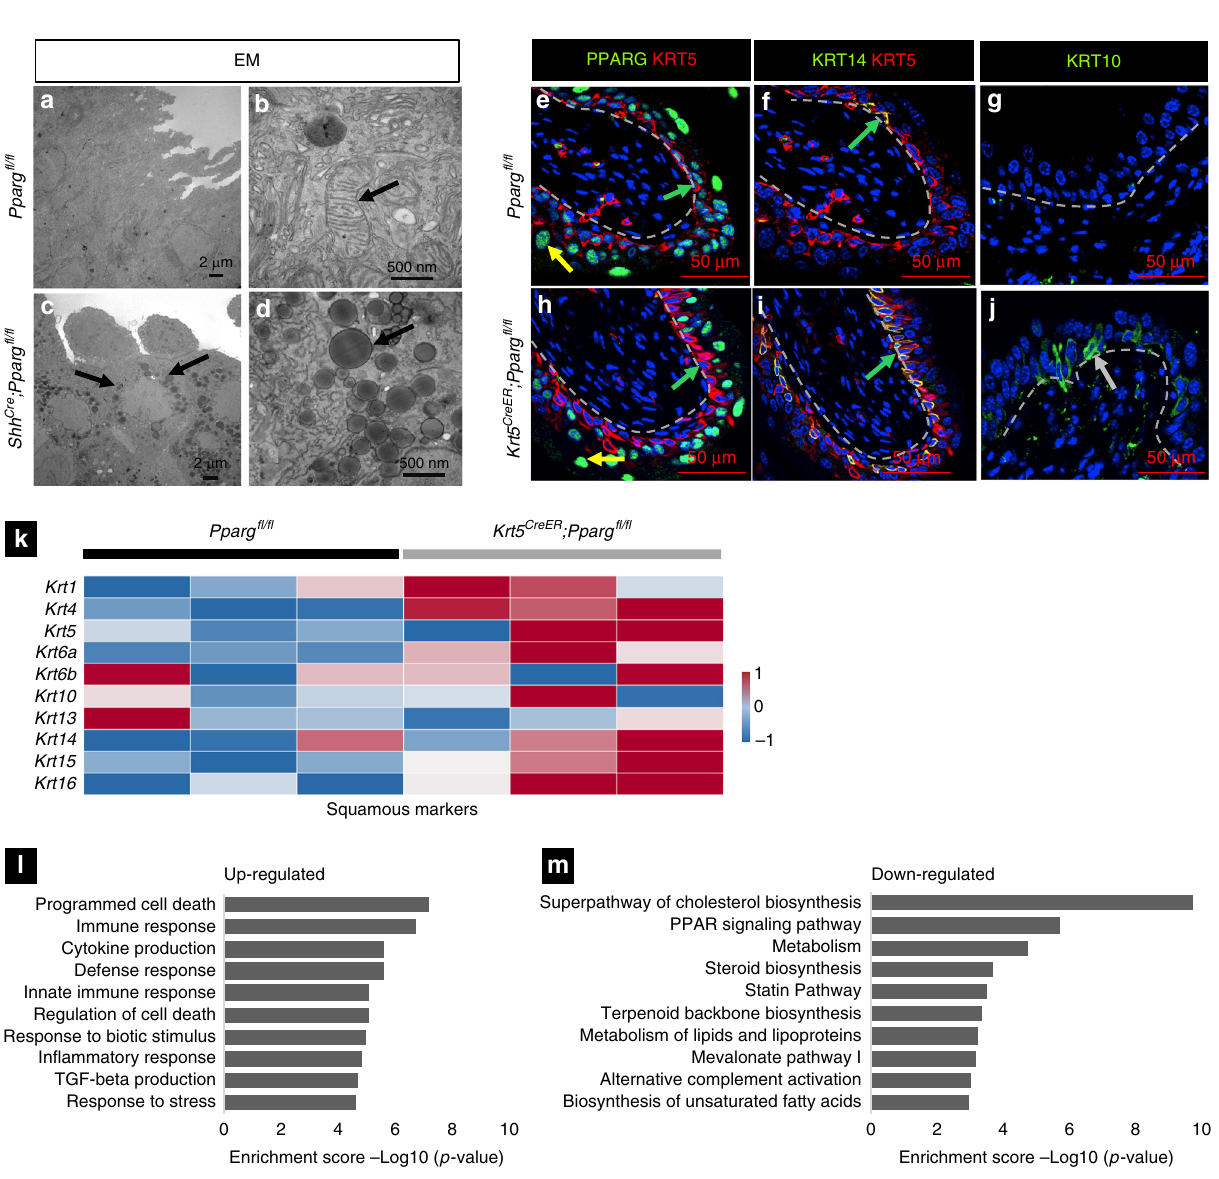
Pparg controls NF- κ B signaling in the urothelium . During homeostasis, about 90% of basal cells are K5-basal cells, while K14-basal cells make up the remaining 10% of the population in the wild-type urothelium. We observed expansion of the K14- basal population in adult Shh Cre ;Pparg fl / fl mutants during homeostasis that persists for as long as 1 year; however, we did not observe evidence of squamous metaplasia or tumor formation during homeostasis (Supplementary Fig. 1k – n). The urothelium is largely quiescent during homeostasis, but can rapidly